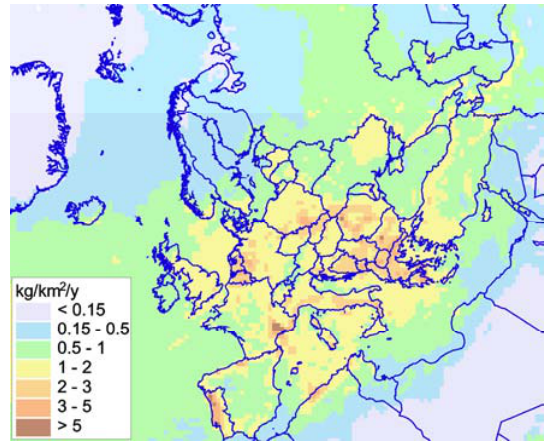
Fig 4. Spatial distribution of lead depositions in Europe in 2004